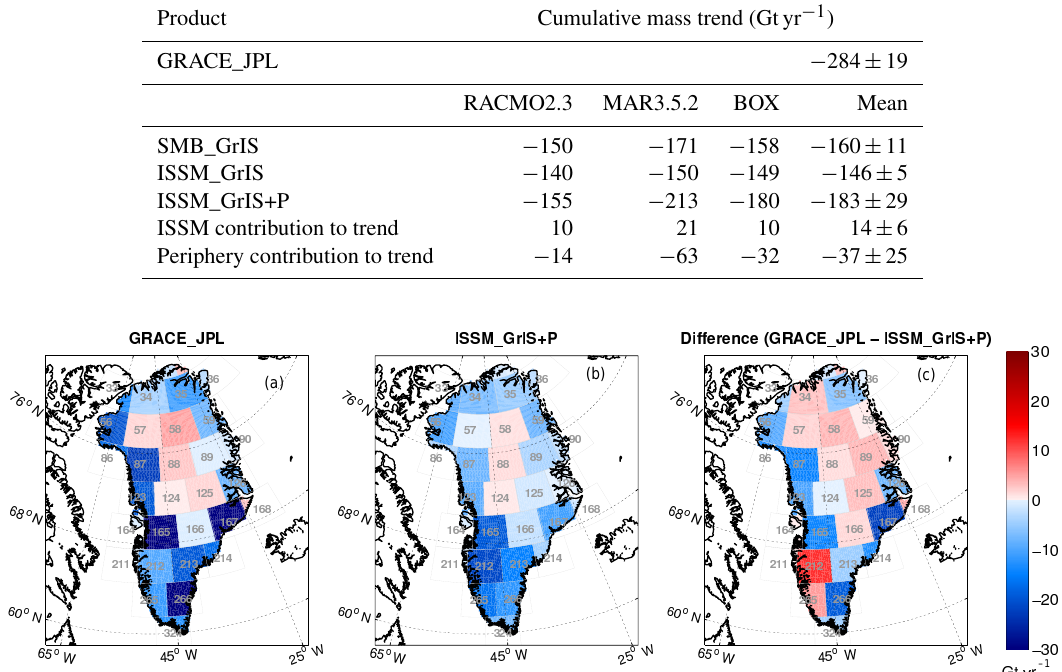
Figure 4. Spatial representation of trend in surface mass over Greenland from (a) GRACE_JPL, (b) ISSM_GrIS+P, and (c) the difference between GRACE_JPL and